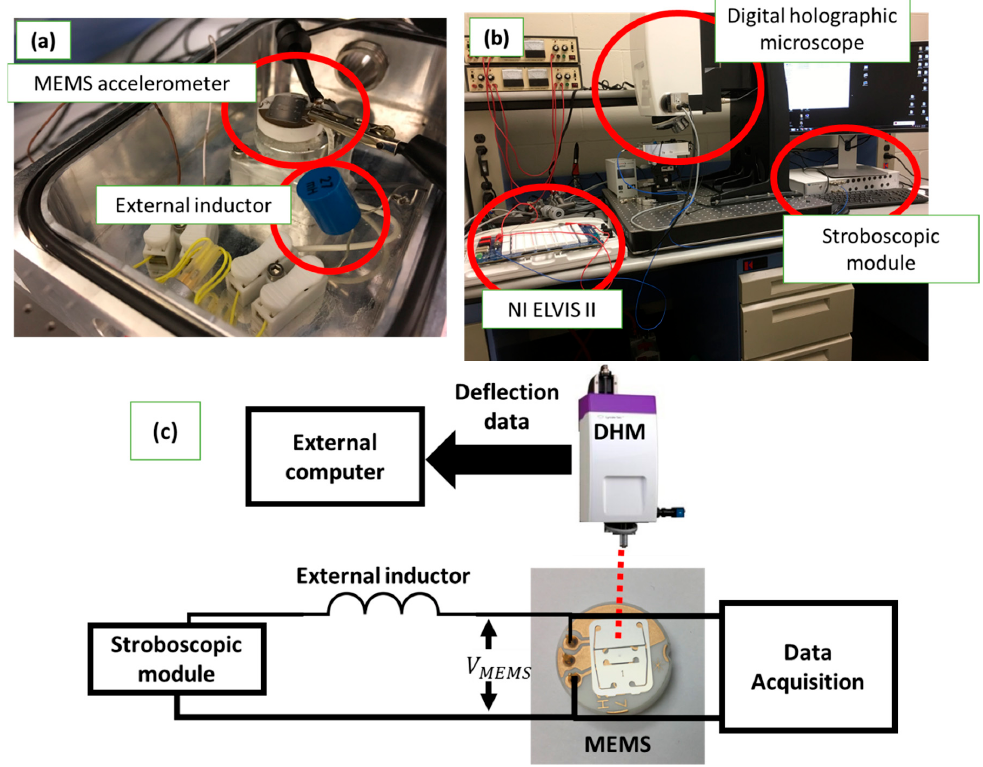
Figure 3. Experimental setup. ( a ) Circuit connection showing the accelerometer and the external inductor. ( b ) The equipment used for measurements: NI ELVIS II, DHM, and stroboscopic module. ( c ) The connection schematic.